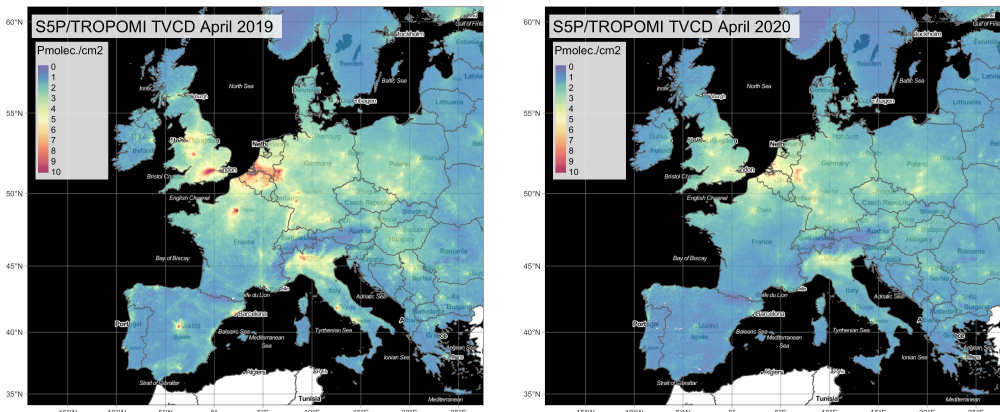
Figure 12. Comparison of the average tropospheric vertical column density (TVCD) of NO 2 retrieved from the TROPOMI instrument on board of the Sentinel-5P platform for April 2019 ( left panel ) and April 2020 ( right panel ). Units are given in 10 15 molecules per square centimetre. Basemap copyright OpenStreetMap contributors and map tiles by Stamen Design, under CC BY